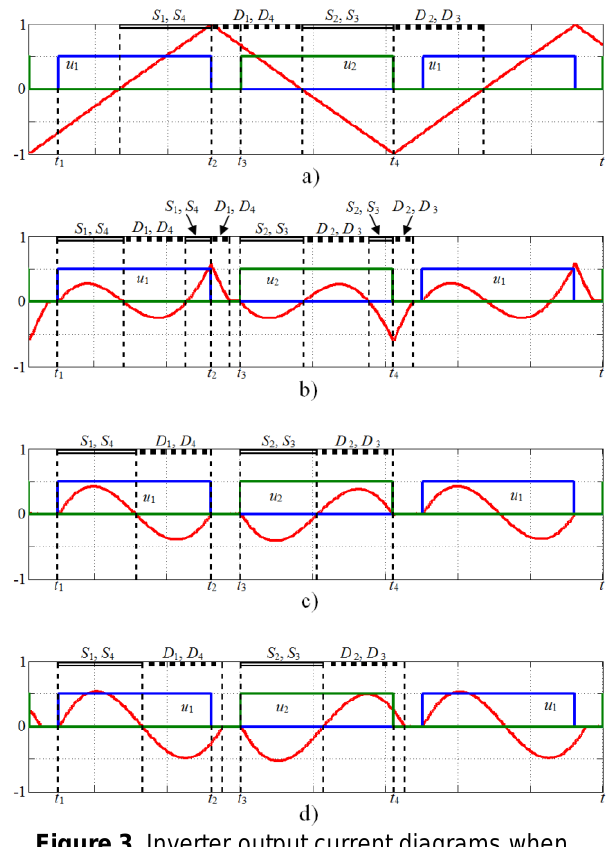
Figure 3. Inverter output current diagrams when changing the resonant circuit